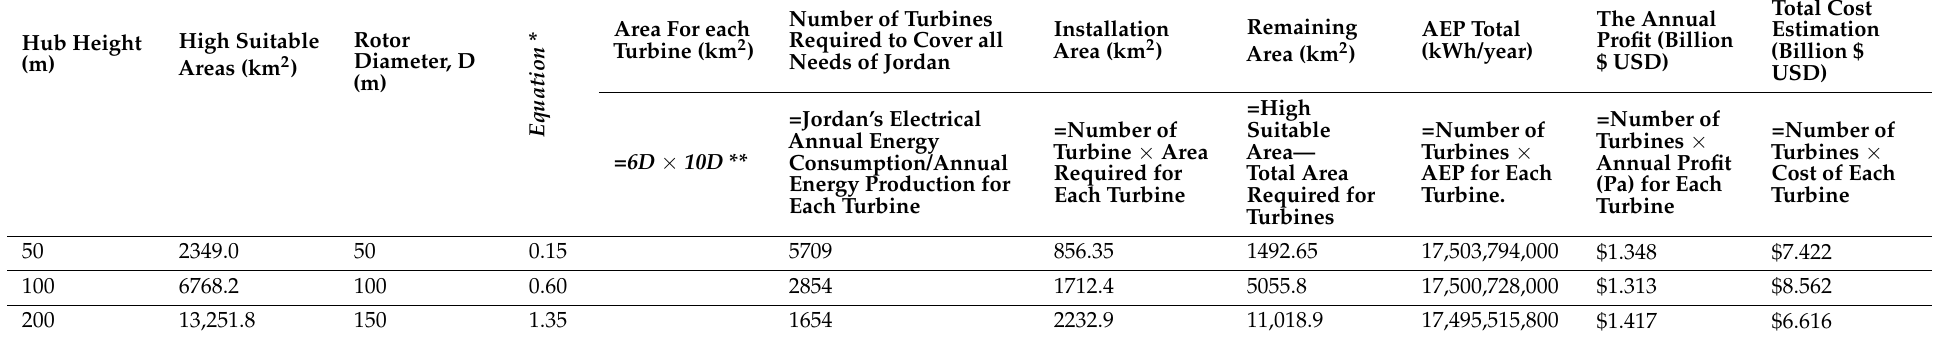
Table 3. Feasibility of Installing Wind Turbines in the Northern Region/Mafraq Governorate for High Suitable Areas Class at Three Heights (50 m, 100 m, and 200 m).